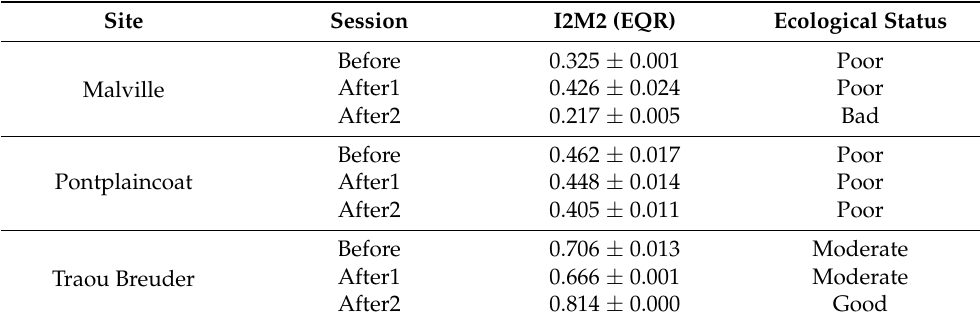
Figure 3. Boxplots representing the I2M2 median values ( ± 25th and 75th percentile) and the five taxonomy-based metrics in terms of Ecological Quality Ratio (EQR) in the three streams. Different lower-case letters represent significant differences according to the results of Tukey’s posthoc tests (ASPT: Average Score Per Taxon; Richness: taxonomic richness and Shannon: Shannon’s diversity index; Ovoviviparity: relative abundance of ovoviviparous species; polyvoltinism: relative abundance of the polyvoltine species). Table 2. Ecological status (I2M2) of the three streams before and after restoration (Before: before restoration; after1: first year of monitoring after restoration; after2: second year of monitoring after restoration) according to the five taxonomy-based and trait-based metrics. The threshold values used to define the ecological status classes are those from [28]. These threshold values are respectively: 0.870; 0.733; 0.488; 0.244. Values are expressed as mean ± variance in terms of Ecological Quality Ratio (EQR).